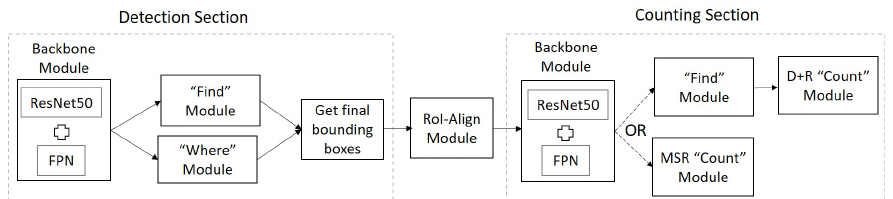
Figure 2. The Detection and Counting Network. The network includes two separate sections for ob- ject detection and part counting, connected by an object re-sampling layer. See Sections 2.2.1 and 2.2.2 for module